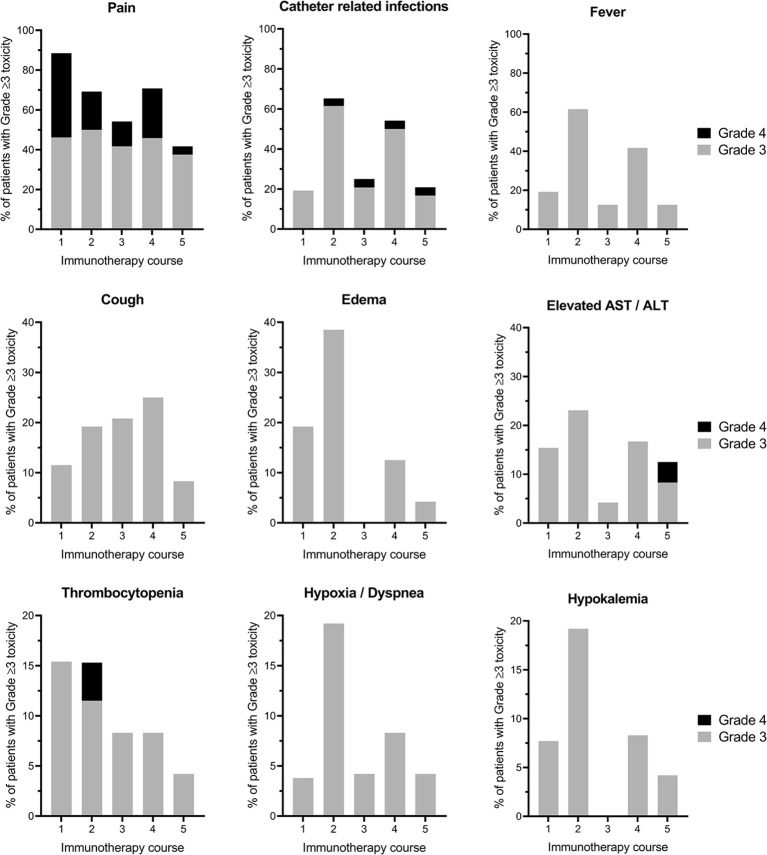
The most prevalent immunotherapy-related grade ≥3 toxicities per course. Proportion of patients experiencing grade ≥3 toxicities per cycle (1–5) of immunotherapy are displayed. The highest grade of toxicity per patient per course is shown. Please note the different scales of the Y-axis. AST, Aspartate transaminase; ALT, Alanine transaminase.